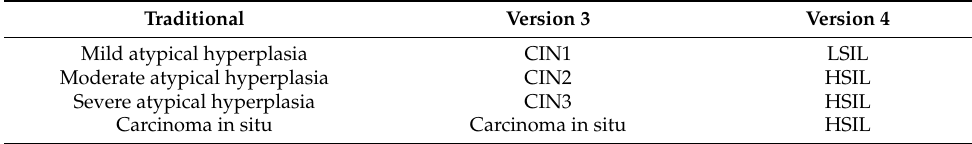
Table 1. Changes in the classification of precarcinoma of cervical squamous cell carcinoma.